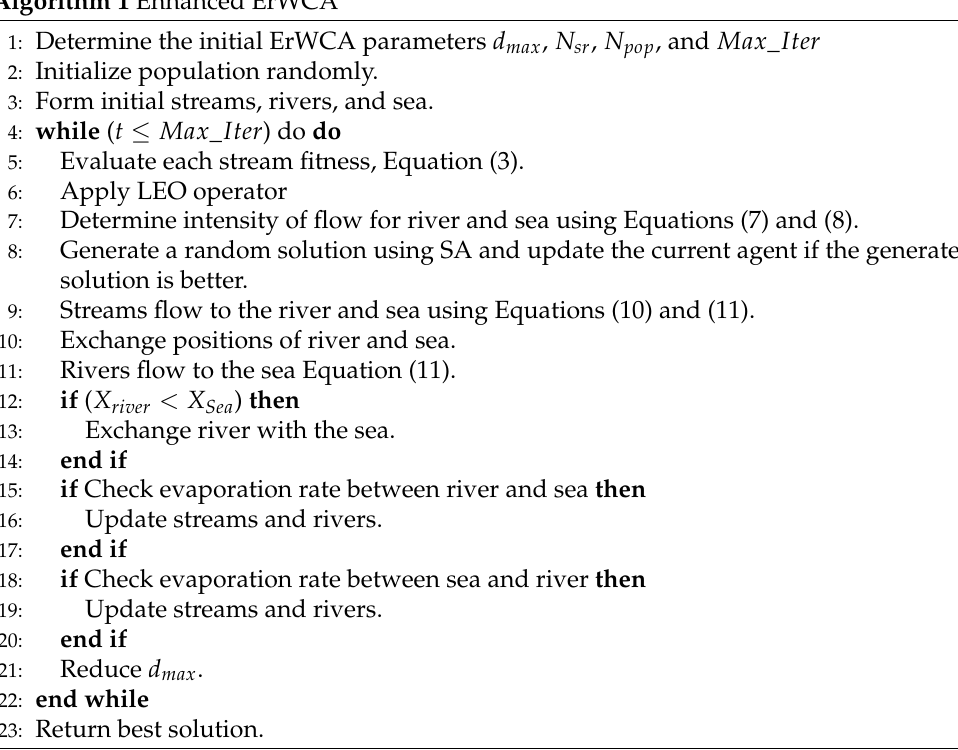
Algorithm 1 Enhanced ErWCA